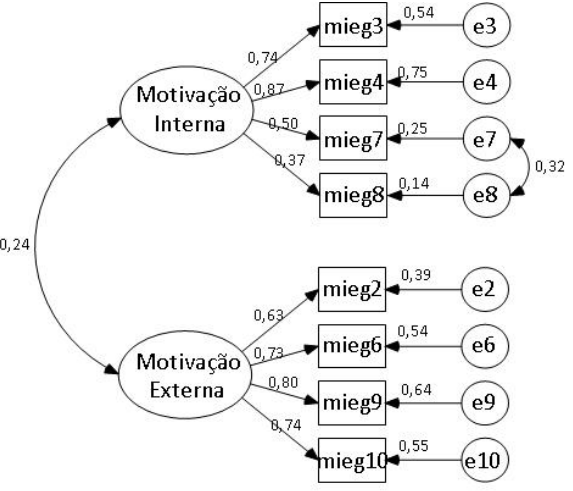
Figura 1. Estrutura fatorial da Escala de Motivações Externa e Interna para Responder sem Preconceito frente a Gays